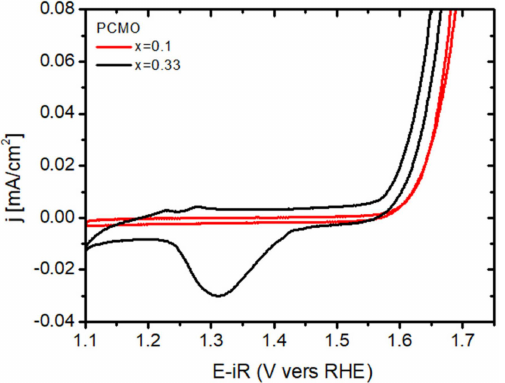
Figure 8. Cyclovoltagramms of (001) oriented PCMO (x = 0.1) and (x = 0.33) films in 0.1 M KOH. The x = 0.33 film shows a redox couple which is overlapping to the onset of OER at the anodic branch and well separated from OER at the cathodic branch. This redox couple is absent for PCMO (x =